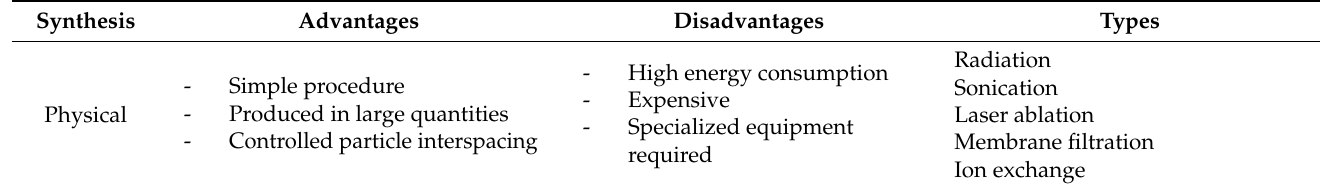
Table 1. Summary of nanoparticle synthesis methods and their advantages and disadvantages.